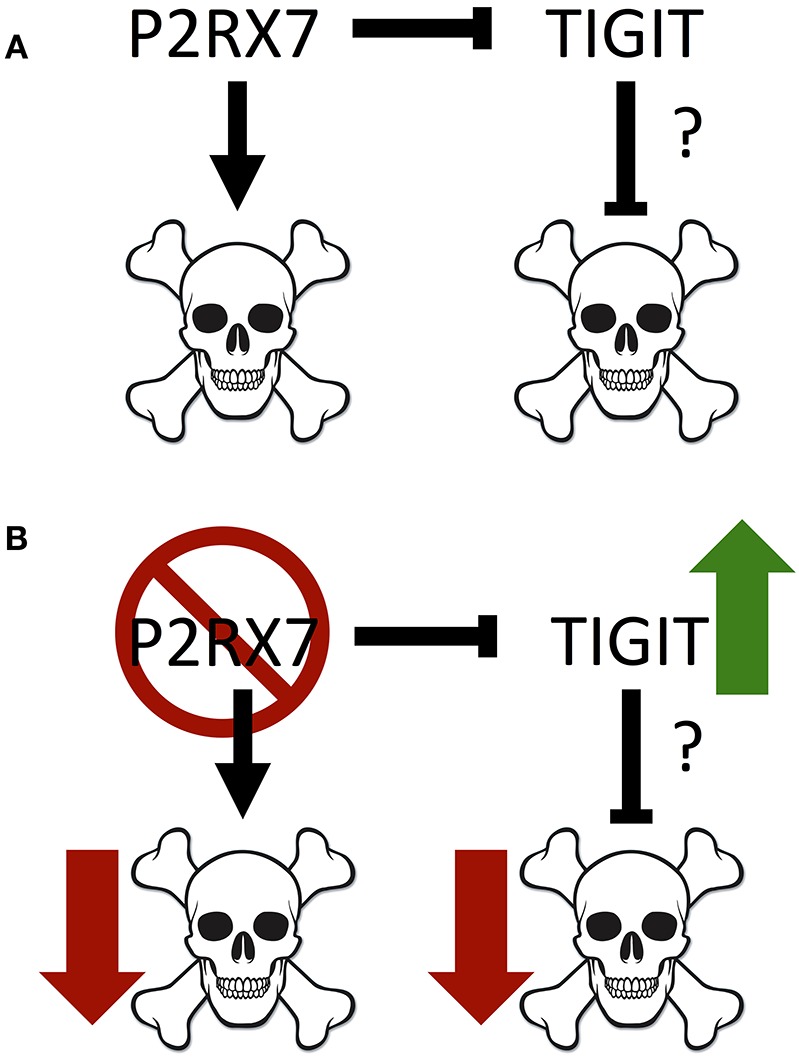
Model of interactions between P2RX7 and TIGIT, and their impact on cell death. (A) P2RX7 promotes apoptosis in PP Tfh cells to regulate Tfh numbers. P2RX7 may also regulate TIGIT expression on Tfh cells. TIGIT, conversely, may inhibit apoptosis to promote Tfh cell survival. (B) In the absence of P2RX7, apoptosis is disrupted, allowing the expansion of the PP Tfh population. In addition, the absence of P2RX7 leads to greater TIGIT expression, which may further down-regulate apoptosis.